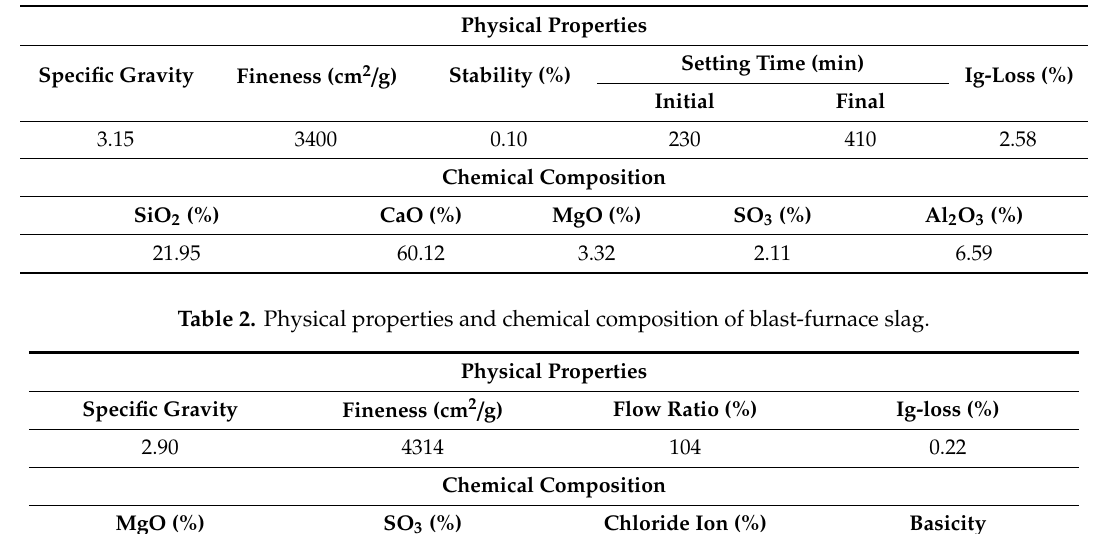
Table 1. Physical properties and chemical composition of ordinary Portland cement.